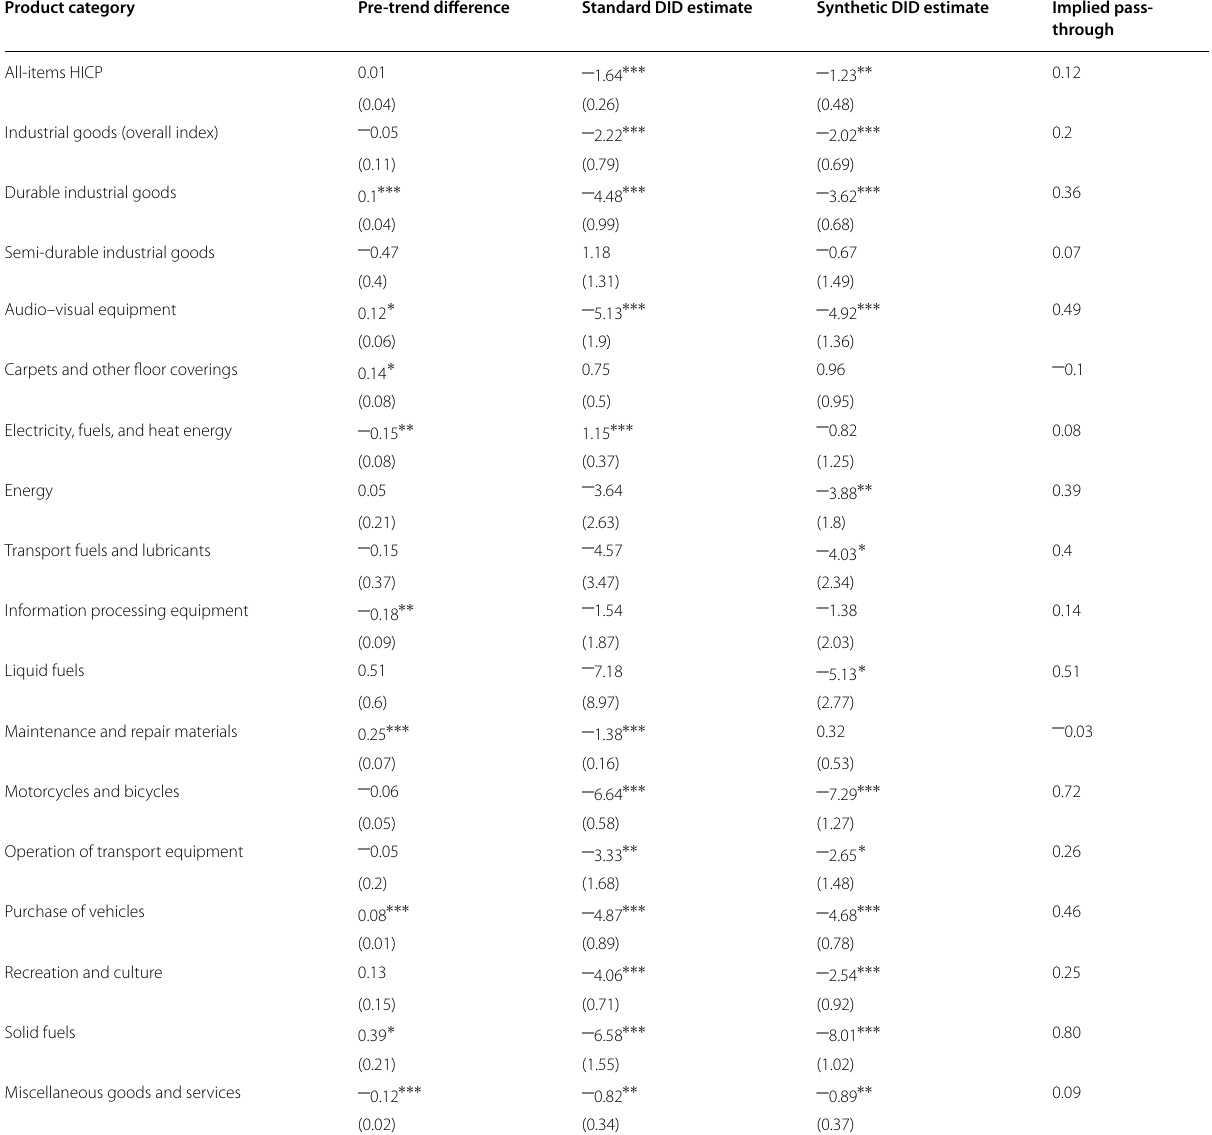
Table 8 Estimates of the exchange rate pass-through to consumer prices for Industrial and Other